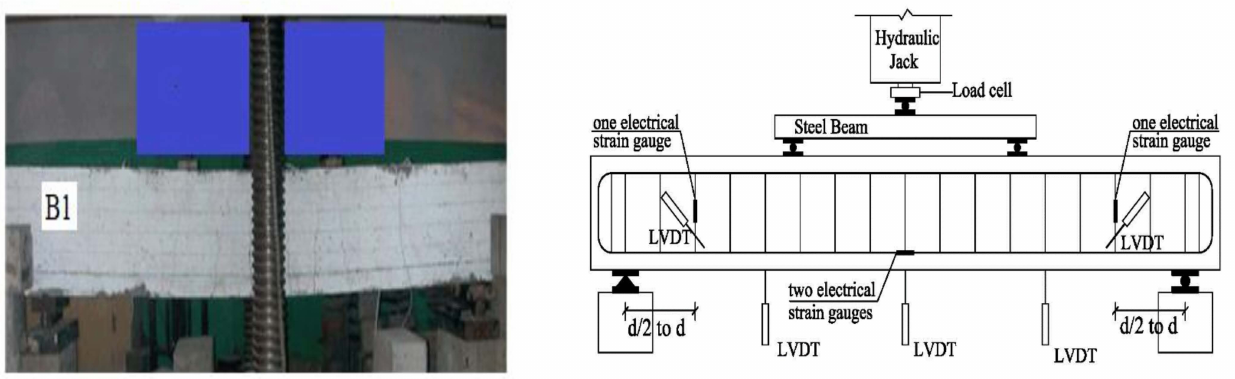
Figure 4. Test setup.